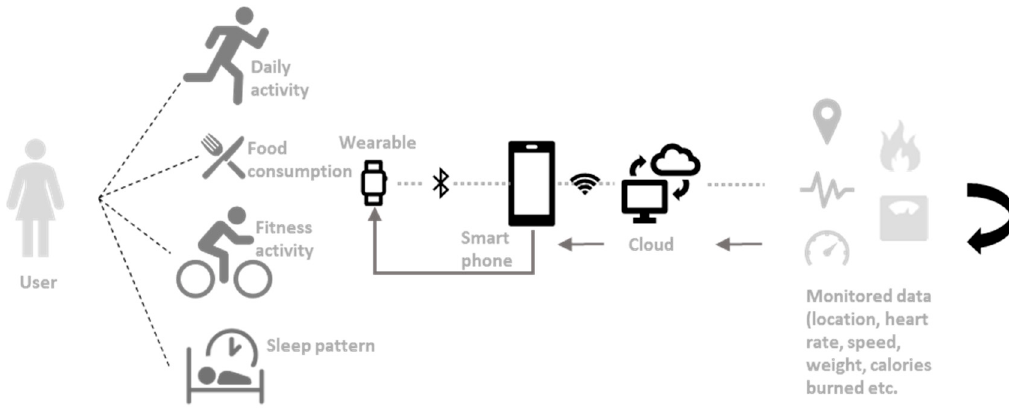
Figure 1. Block diagram example of a Fitness wearable’s process. This shows the example block diagram in how fitness wearable technology can be used for lifestyle applications (weight, calories burned, heart rate, speed, etc.). The users will have their activity monitored via sensors, input some of the data themselves (food eaten), which can then be communicated to a smart phone and to the provider’s cloud service. The data then get processed, thus they become useful for the user to understand. This is fed back into either the paired smart phone or the wearable itself, depending on type of